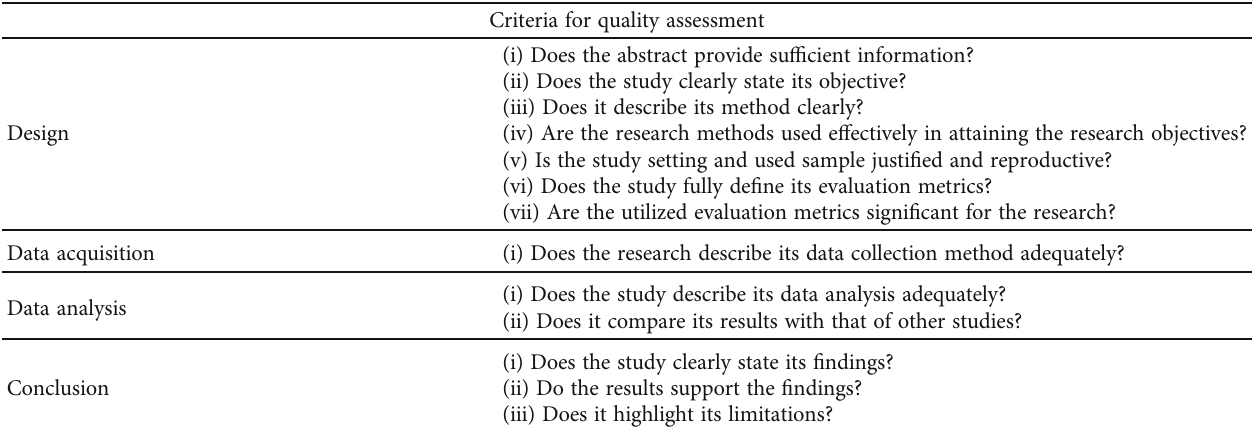
Table 3: Quality assessment and selection